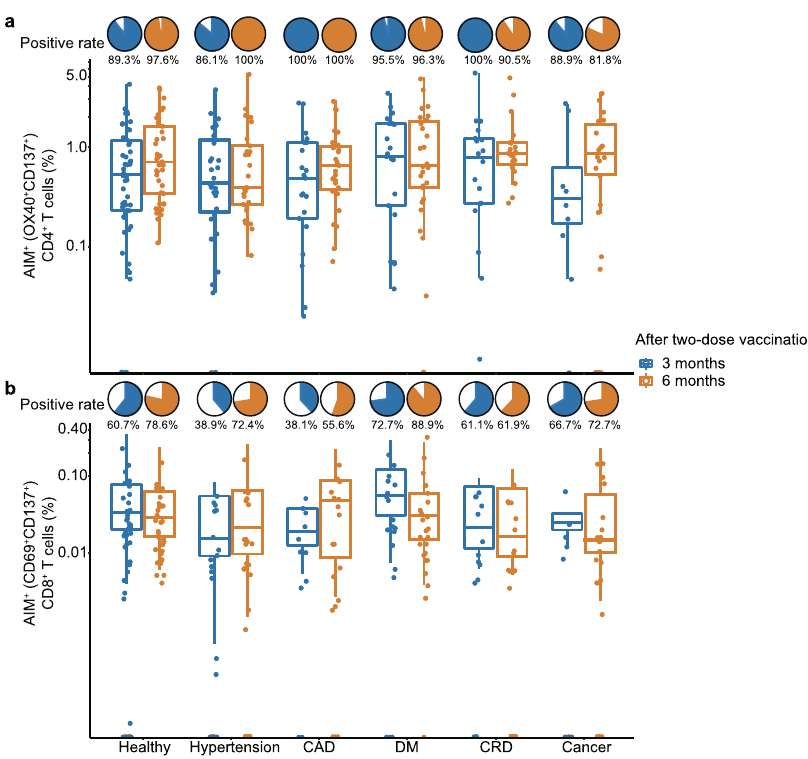
Fig. 4 The SARS-CoV-2-spesi fi c T cell responses after 3 months, and 6 months after two-dose CoronaVac. n = 229 study participants. Box indicates 25th, 50th, and 75th percentile absolute error, and whiskers indicate 5th and 95th percentile absolute error. Blue color refer to 3 months after two-dose vaccination, while orange color refer to 6 months. The detected positive rate and cell fraction of SARS-CoV-2-speci fi c CD4 + T cell responses (OX40 + CD137 + ) ( a ) and the SARS-CoV-2-speci fi c CD8 + T cell responses (CD69 + CD137 + ) ( b ) in different chronic diseases subgroups and healthy control, quanti fi ed by AIM